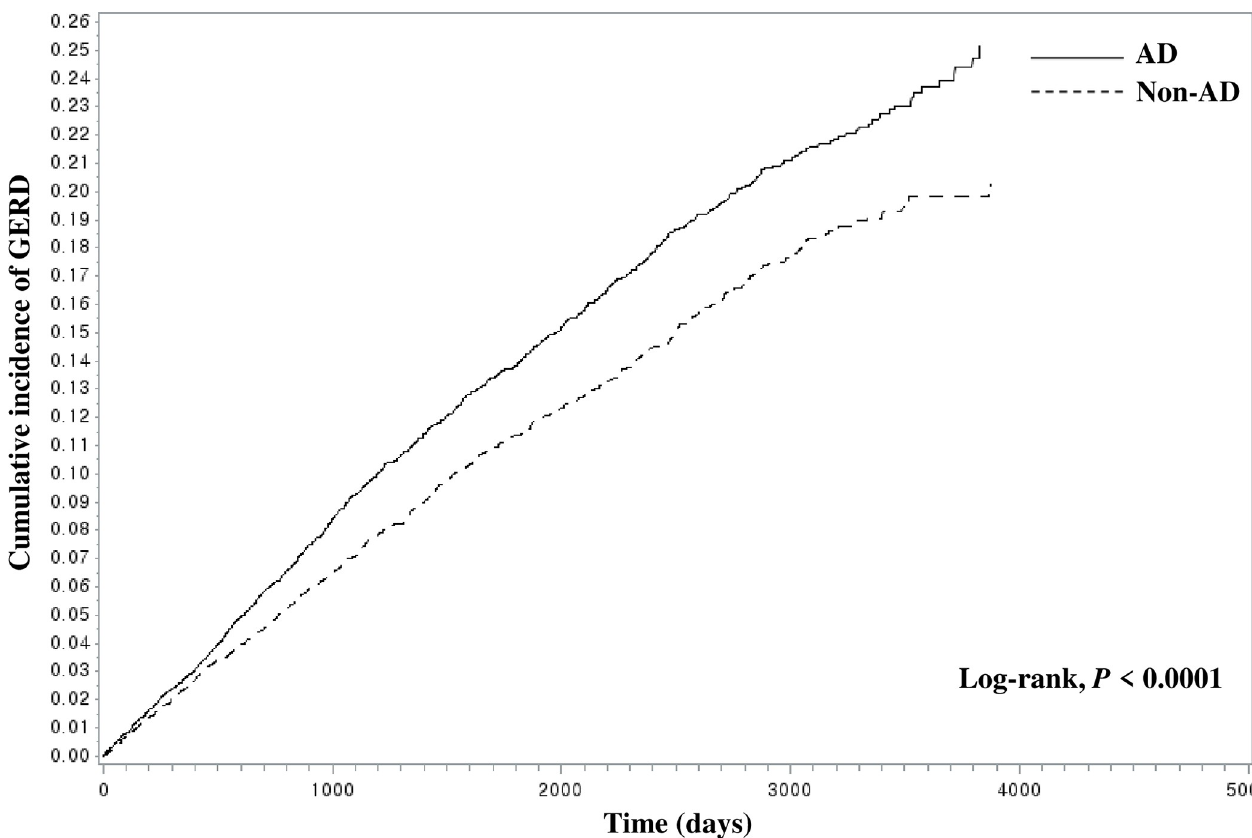
Fig 2. Cumulative incidence of GERD in patients with (solid line) and without AD (dashed line) over time. AD, atopic dermatitis; GERD, gastroesophageal reflux disease.